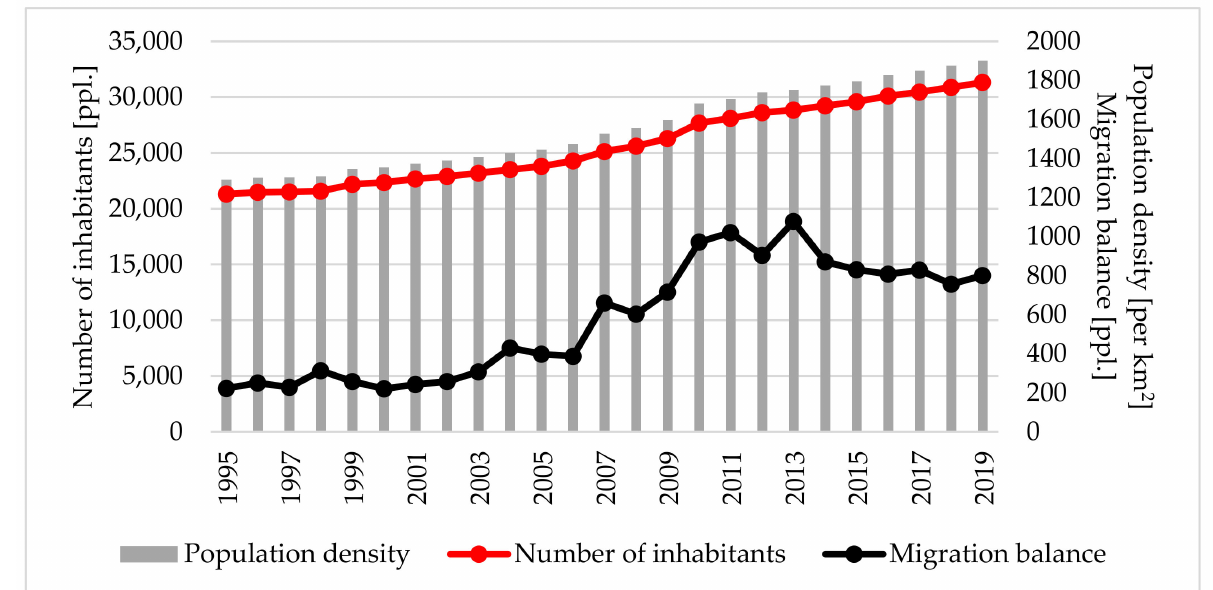
Figure 2. Dynamics of the demographic indicators of Pruszcz Gda´nski in the period 1995-2019 (source: own elaboration based on BDL [67] and Municipal Office of Pruszcz Gda´nski